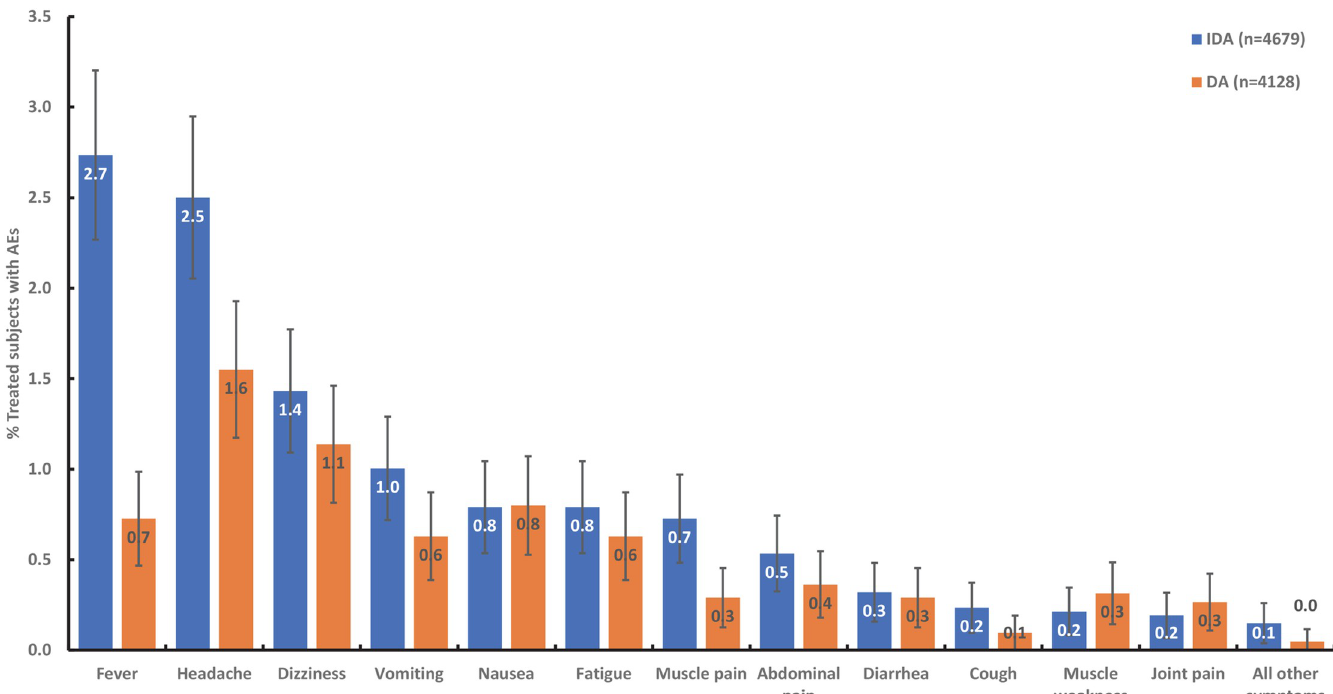
Fig 4. No. of persons with the most commonly observed AE by treatment regimen expressed as percentages of participants who were assessed for AE after treatment. A participant was counted only once for each AE type (e.g., a subject can only have a single headache). But if a participant experienced different AE types he/ she was included in the numerator of each AE type (e.g., if a subject experience a headache and fatigue, then they will be included in the numerator for both of these AE categories). AE, adverse event; DA, double-drug therapy (diethylcarbamazine, albendazole); IDA, triple-drug therapy (ivermectin, diethylcarbamazine,